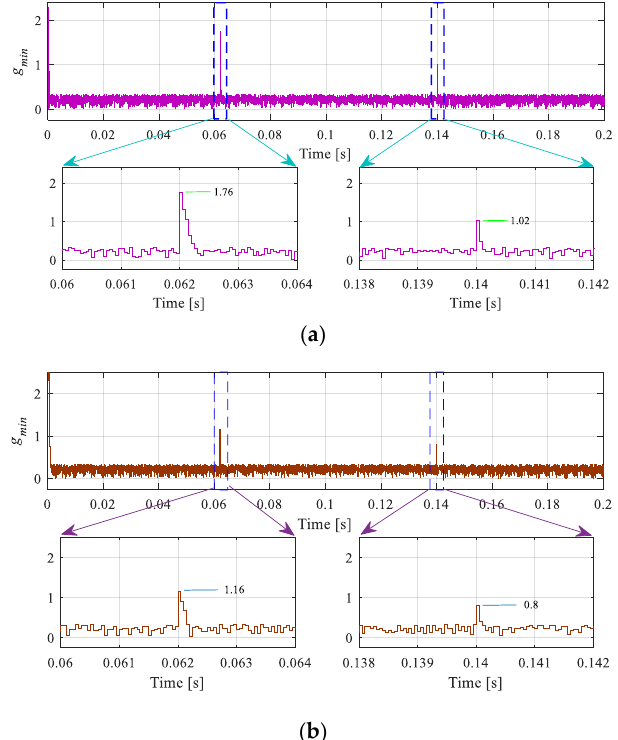
Figure 8. Simulation results: the values of minimum cost function g min for the FS-MPC in ( a ) αβ -frame and ( b ) dq -frame.